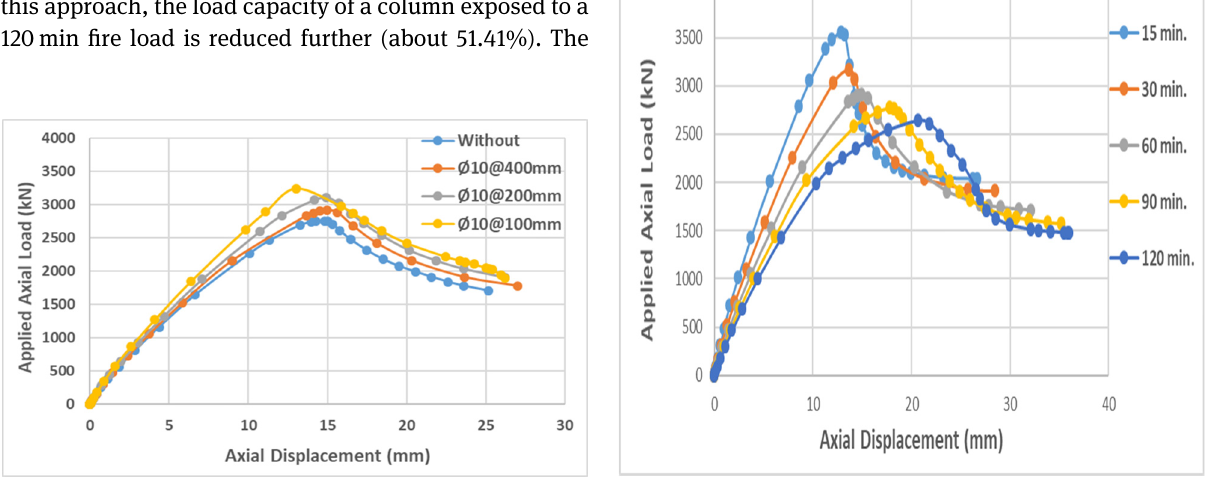
Figure 10: Numerical load - vertical displacement of RC column with di ff erent spacings of ties at 600°C.